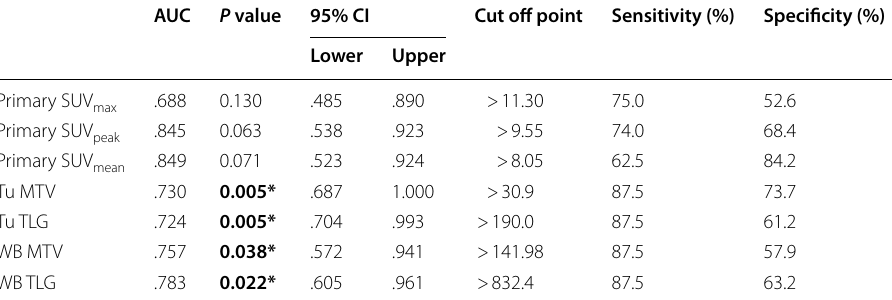
Table 2 ROC analysis, AUC, and Optimal Cutoff Value of Each Metabolic Parameter